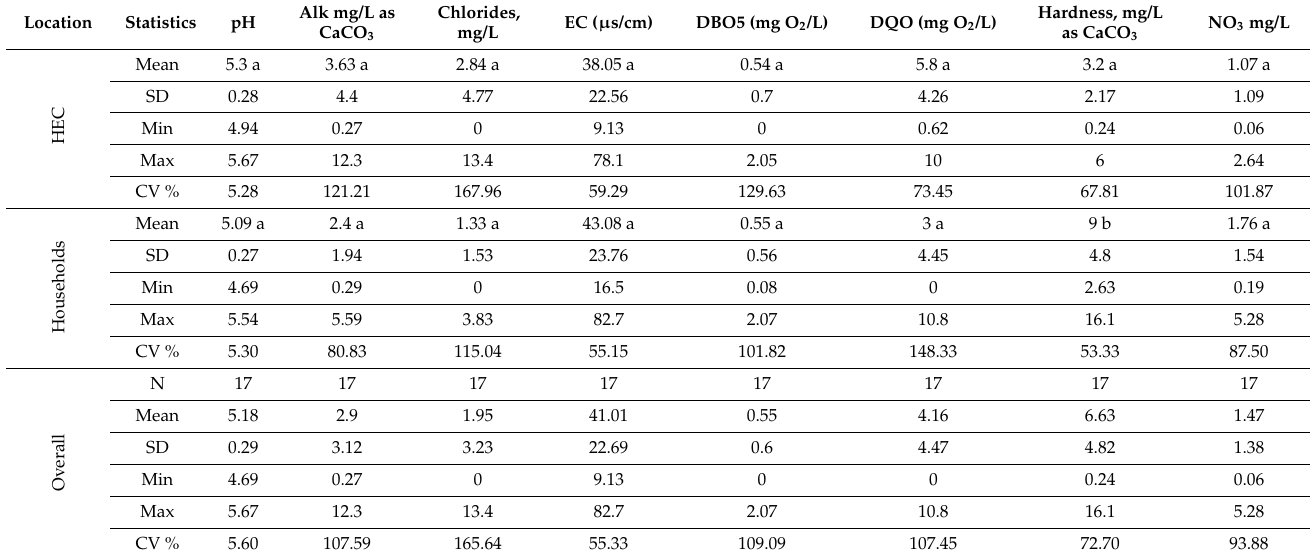
Table 2. Descriptive statistics of the dataset obtained from the monitored wells in a rural